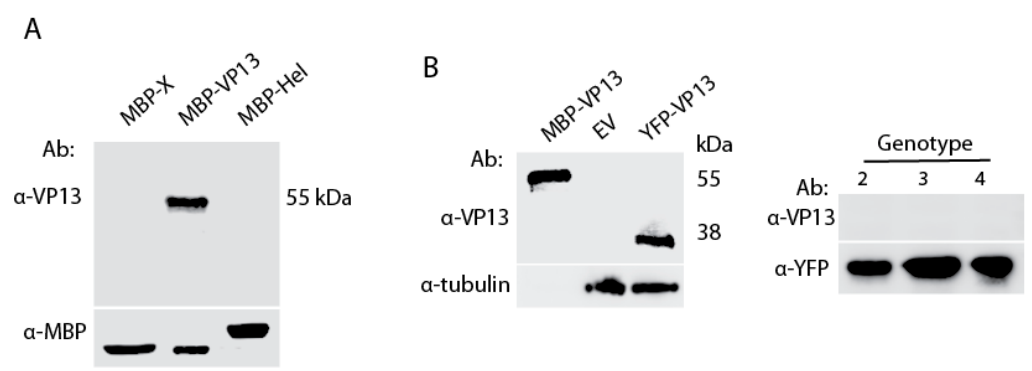
Figure 1. Genotype 1 VP13 protein reacts with the monoclonal antibody (Mab) in western blotting (WB). ( A ) Detection of purified maltose ‐ binding protein (MBP) ‐ VP13, but not MBP ‐ X or MBP ‐ Helicase. MBP detection was done as a control; ( B ) Detection of only genotype 1 VP13 in lysate of HEK293 cells transiently transfected with YFP ‐ VP13 plasmids or empty vector (EV). Purified MBP ‐ VP13 was included as a positive control. Ab: antibody.